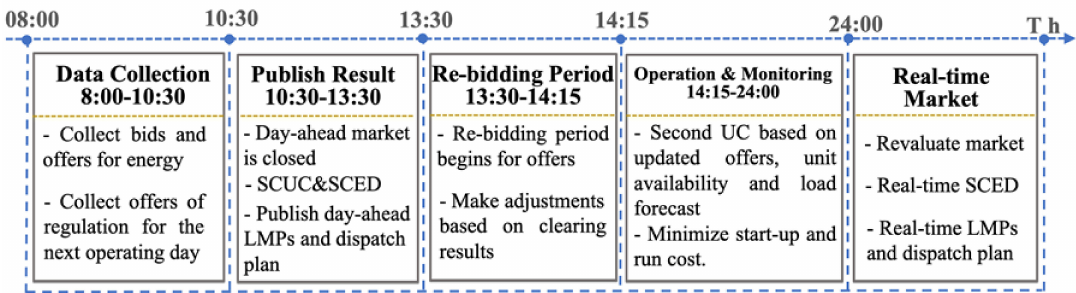
Figure 3. Clearing process of Pennsylvania-New Jersey-Maryland interconnection (PJM) market